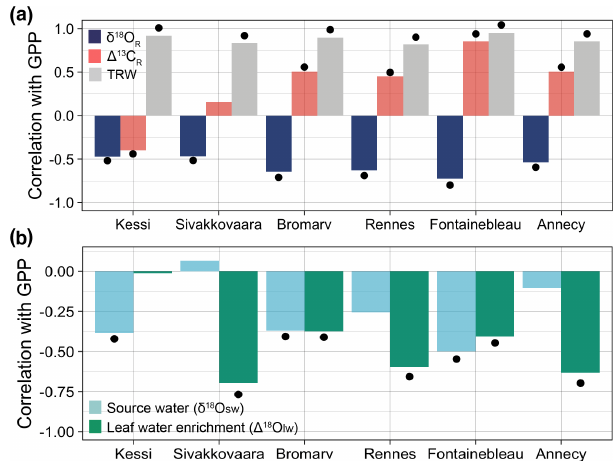
Figure 6. Correlations between the simulated tree-ring variables at each site and simulated May–August gross primary productiv- ity (GPP) over the evaluation period 1960–2000. (a) Correlations of δ 18 O R (dark blue), (cid:49) 13 C R (light red), and tree-ring width (gray) with GPP. (b) Correlations of soil and leaf water δ 18 O components of δ 18 O R with GPP. For Annecy the period of analysis is 1971– 2000. Significance at the 95% confidence level is indicated by the black